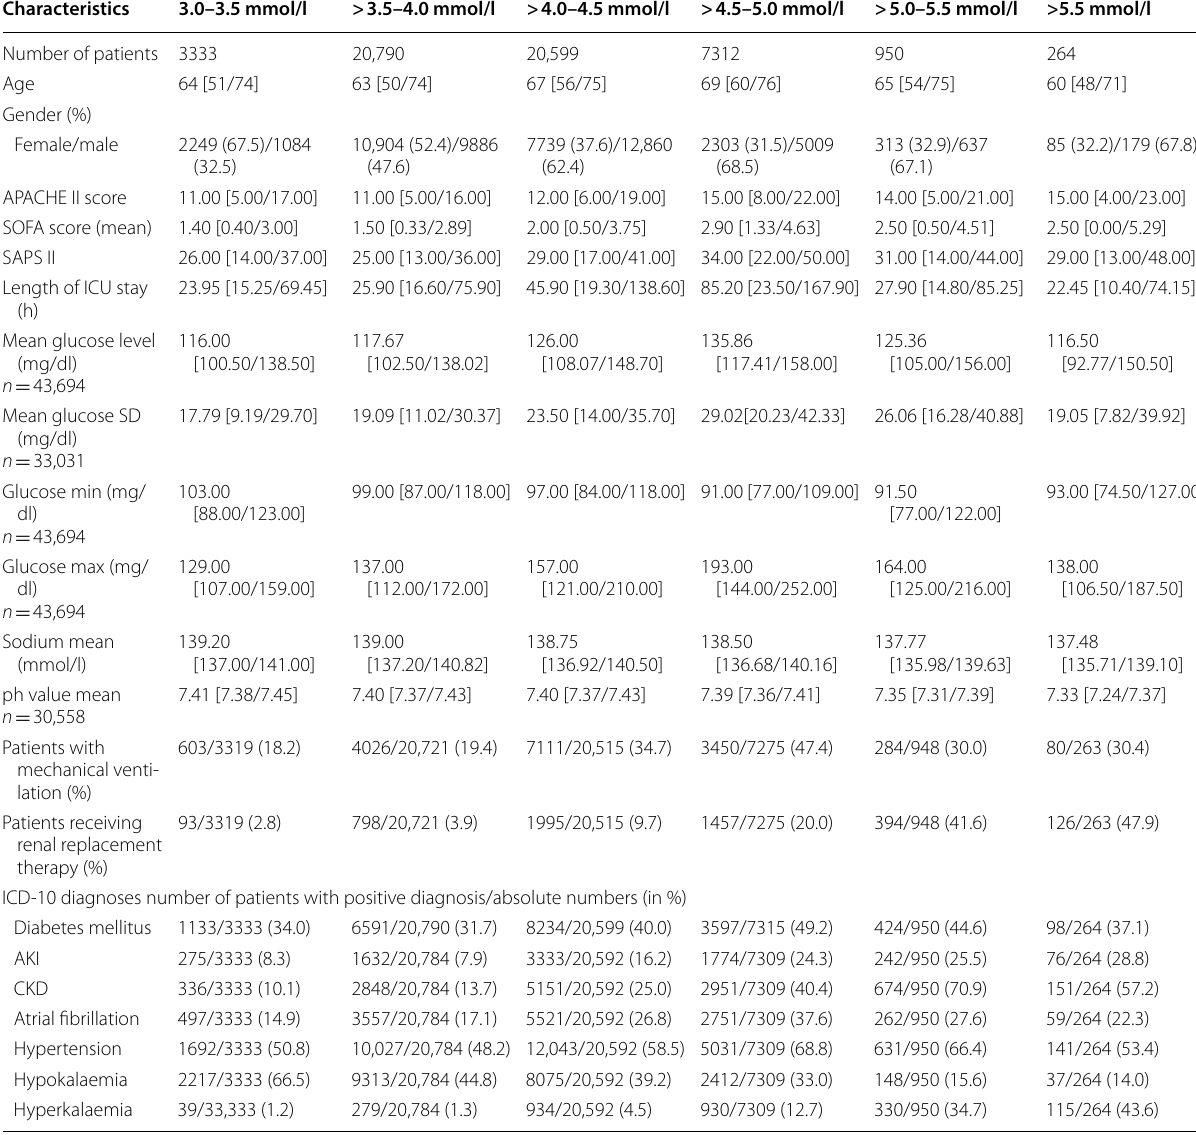
53,248 patients =